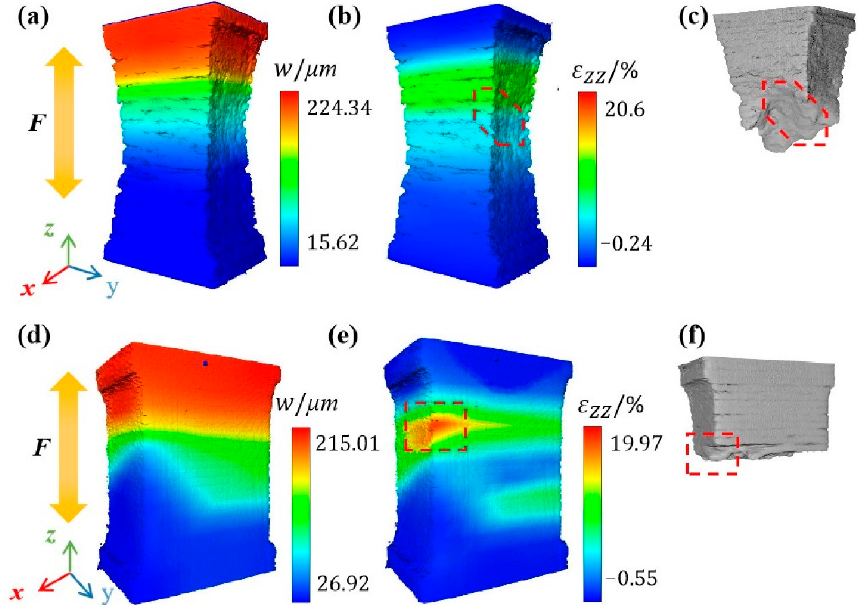
Figure 10. The displacement ( W ) field, uniaxial strain ( ε zz ) field and 3D rendering image of fracture of the VOI1 in ( a – c ) Specimen 400 and ( d – f ) Specimen 1000.